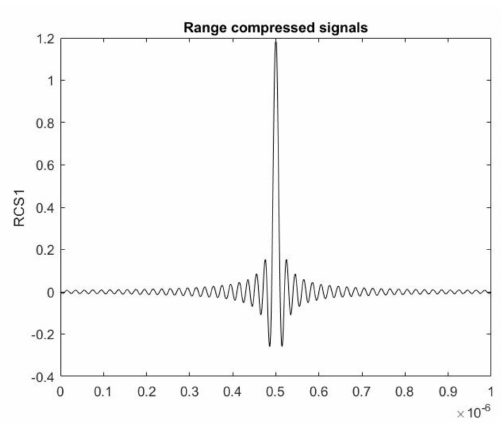
Figure 5. A range compressed signal RCS1 with time delay 0.5 µ s .